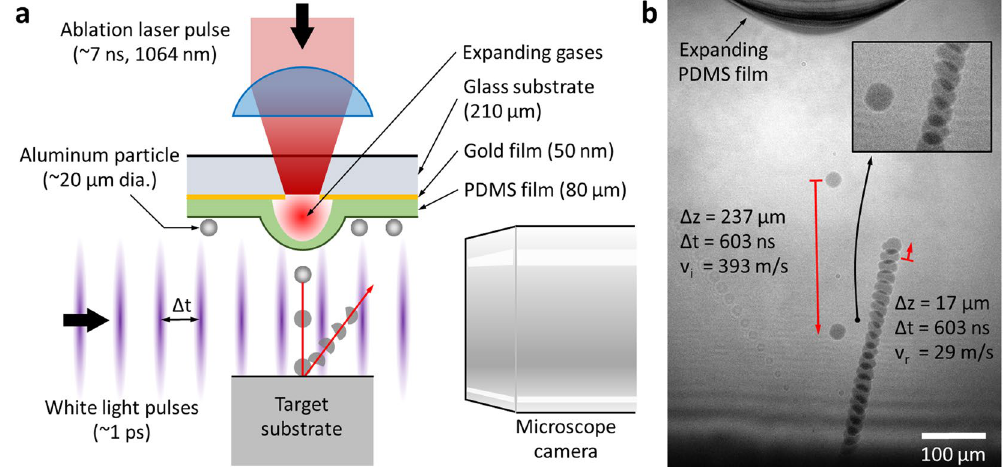
Figure 1. The single aluminum particle impact experiments. ( a ) Scheme of the laser-induced single particle impact experiment. ( b ) 25-times exposure photograph of a colliding and rebounding Al-particle with a 603 ns interval at 1.2 µ s after an ablation laser pulse. This inset is a magnified image showing a change of the Al- particle’s shape and a rotational motion of 75,800 revolutions per